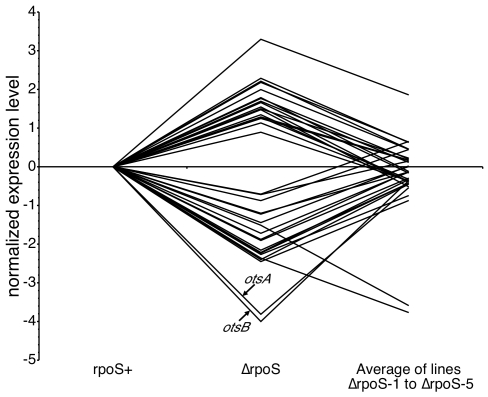
Expression of the 37 genes with changed expression patterns in all five ΔrpoS lines.For 35 of 37 genes, the mean level of expression in the evolved lines is closer to the rpoS+ level than the ΔrpoS ancestor is. The log-transformed expression levels normalized to the rpoS+ value are shown. otsB and otsA are the two genes with the lowest values in the ΔrpoS strain.